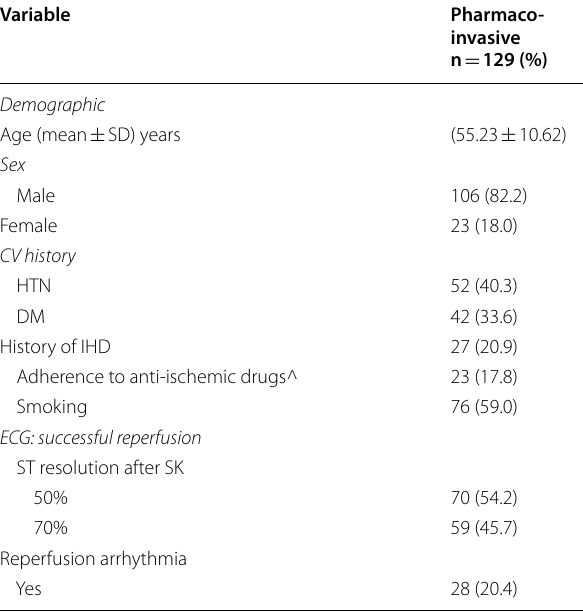
Table 1 Baseline patients’ characteristics and